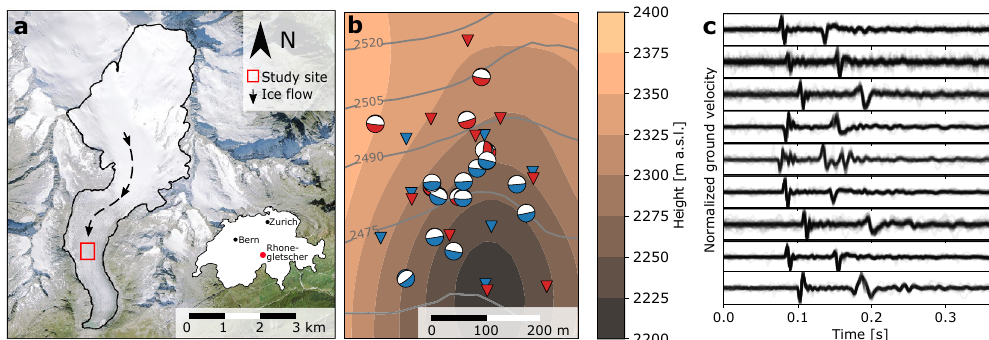
Figure 1. Study site with stick–slip asperities and seismogram. ( a ) Orthoimage of Rhonegletscher and study site. ( b ) Zoom into the red rectangle of a. Background shows the bedrock topography from interpolated ground- penetrating-radar surveys 29 . Surface topography is indicated by gray contours. Red (blue) triangles indicate seismic sensor array in summer (winter). Red (blue) beach balls show focal mechanisms of individual summer (winter) stick–slip clusters. Zoom into dense asperity region is shown in Supplementary Fig. S6. ( c ) Vertical seismograms of events from one cluster. Source of orthoimage in a: Swiss Federal Office of